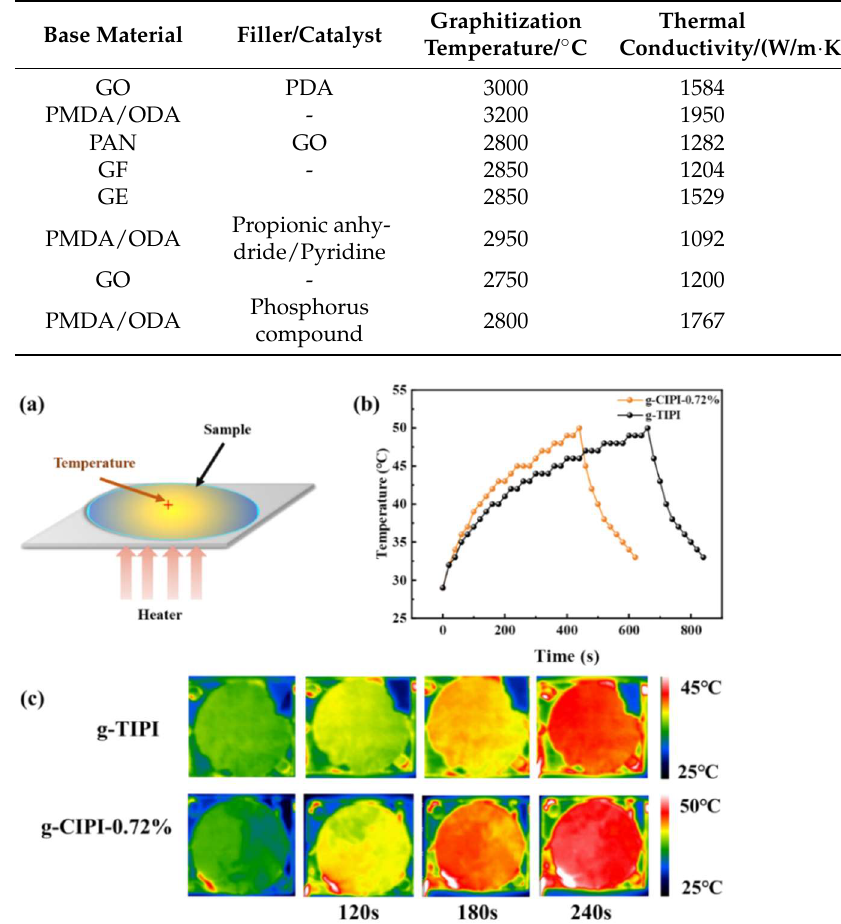
Table 3. Comparison of thermal conductivities of graphite films.